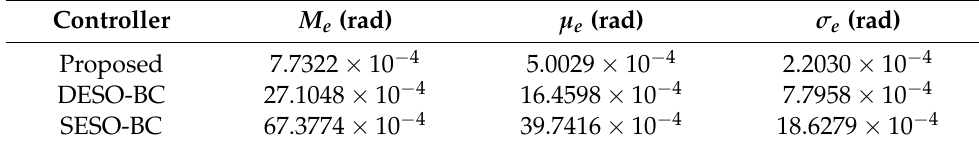
Figure 12. Tracking errors of all controllers in case of sinusoidal reference trajectory. Table 3. Performance indexes of all controllers in the case of the smooth reference